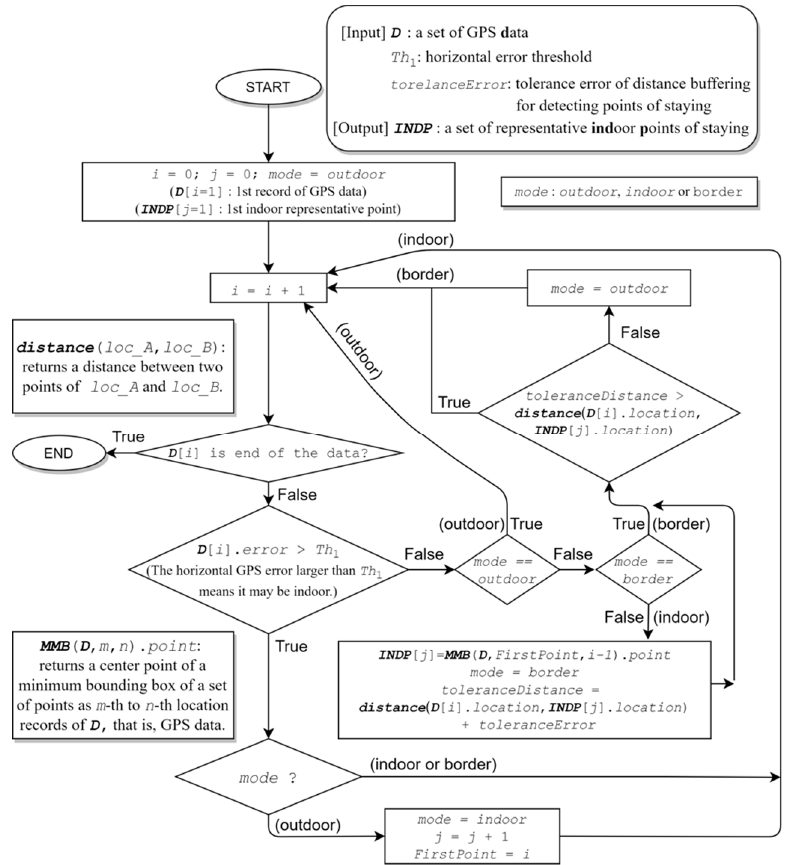
Figure 7. Improved algorithm for extracting a set of points of staying from trajectory data using GPS horizontal accuracy values (including tolerant distance buffering).